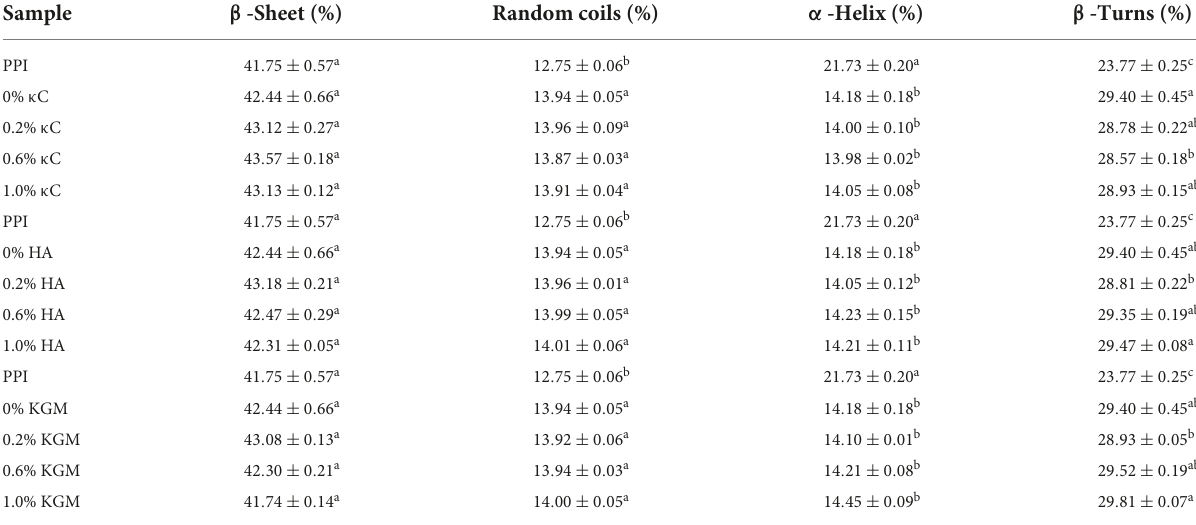
TABLE 4 The composition of β -Sheet, random coils, α -Helix, β -Turns in secondary structure of emulsion gels containing different polysaccharides. Sample β -Sheet (%) Random coils (%) α -Helix (%) β -Turns